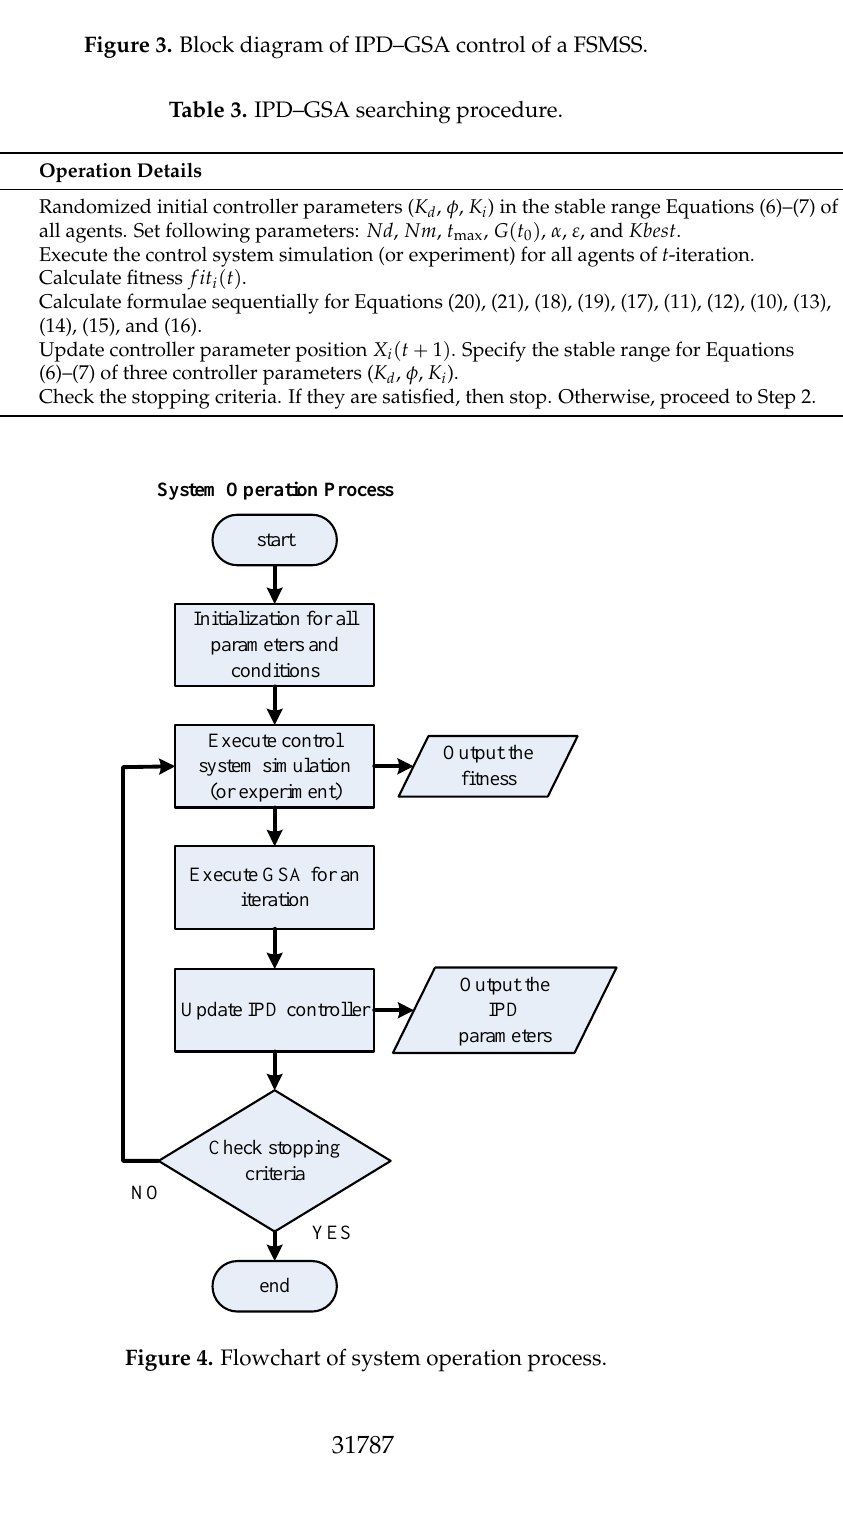
i X Figure 5. Flowchart for executing the control system simulation (or experiment).